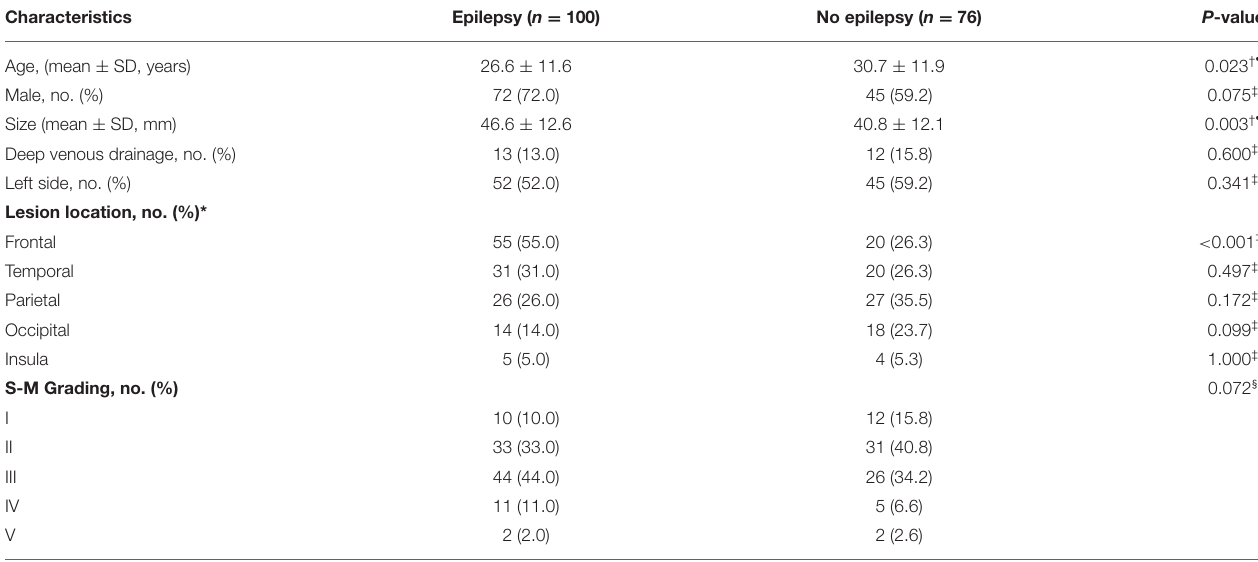
TABLE 1 | Demographic and clinical characteristics of patients. Characteristics